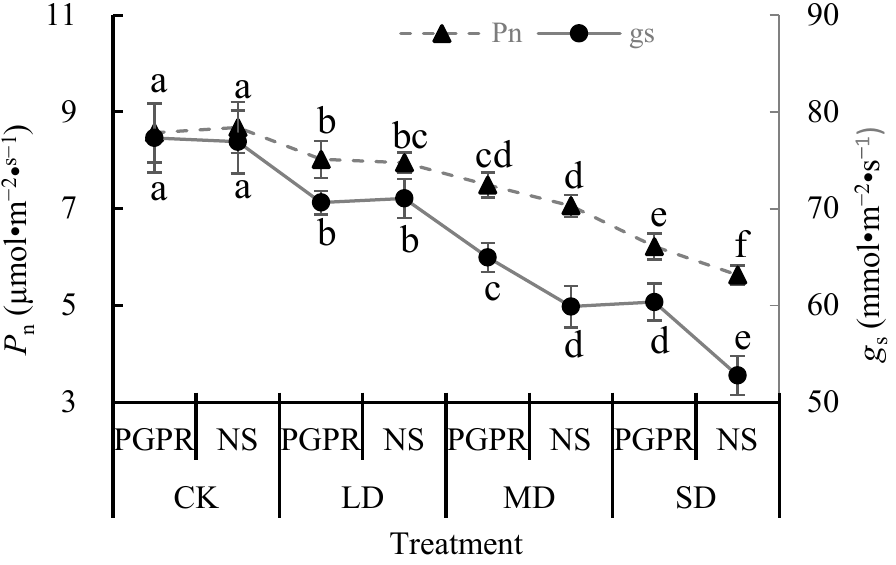
Figure 1. Effects of different drought and inoculation treatments on the P n and g s in the leaves of walnut seedlings. Bars are means, and error bars are standard deviations (n = 6). P n : net photosynthetic rate; and g s : stomatal conductance; CK: normal watering; LD: light drought stress; MD: medium drought stress; SD: severe drought stress. Different letters indicate significant differences among treatments at p < 0.05 by LSD.